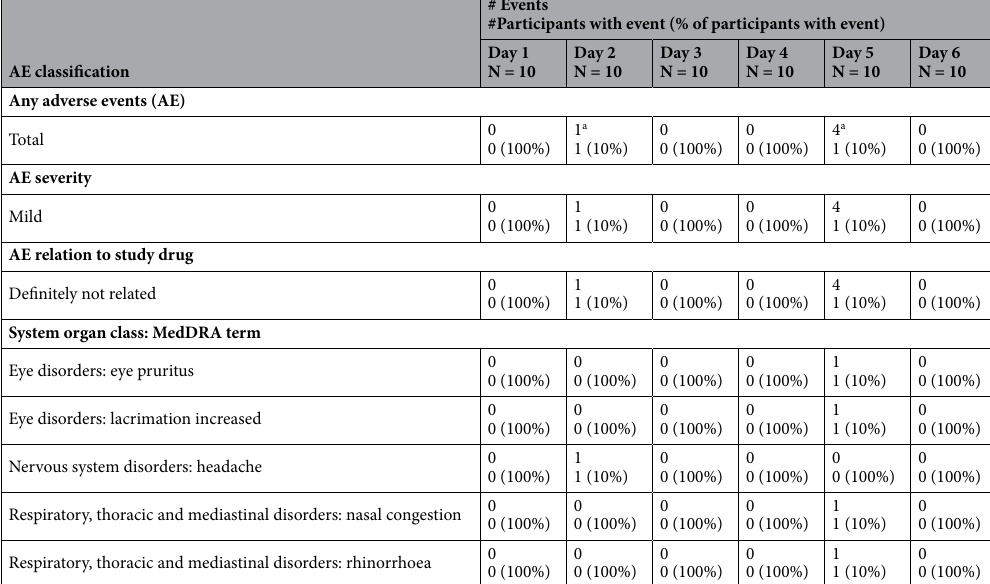
Table 3. Summary of adverse events by study day. a The one AE experienced on day 2 and the four AEs experienced on day 5 all occurred on the same